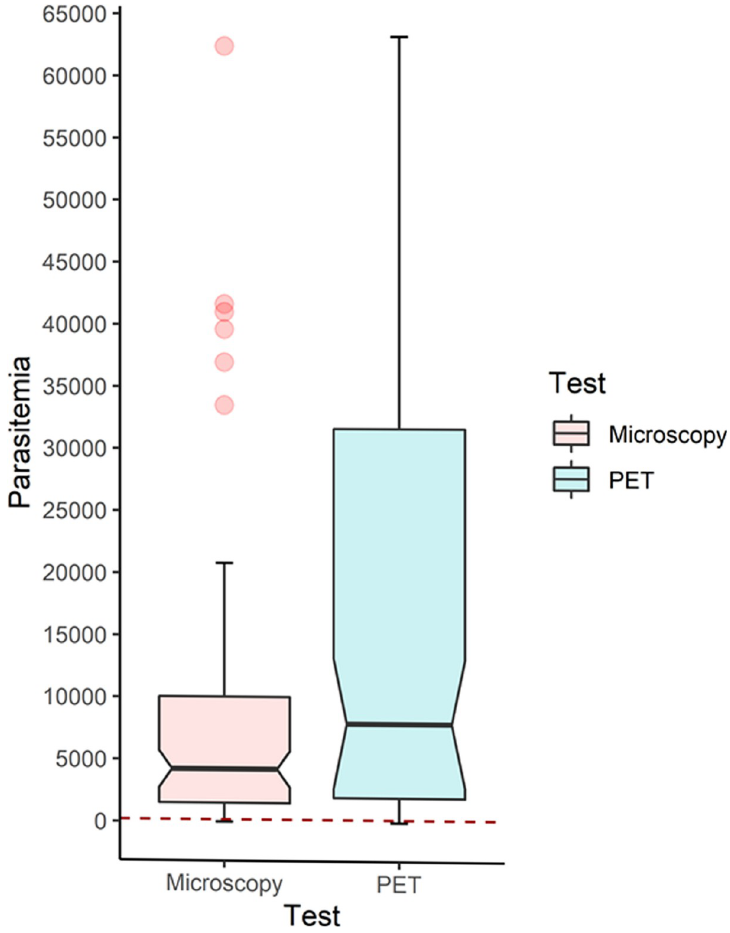
Fig 5. Parasite density distribution. The boxplot shows the distribution of parasite densities estimated by microscopy and PET-PCR along the median and lower and upper quartiles. The optimal parasitemia limit for a Gazelle positive result is shown as a dashed red